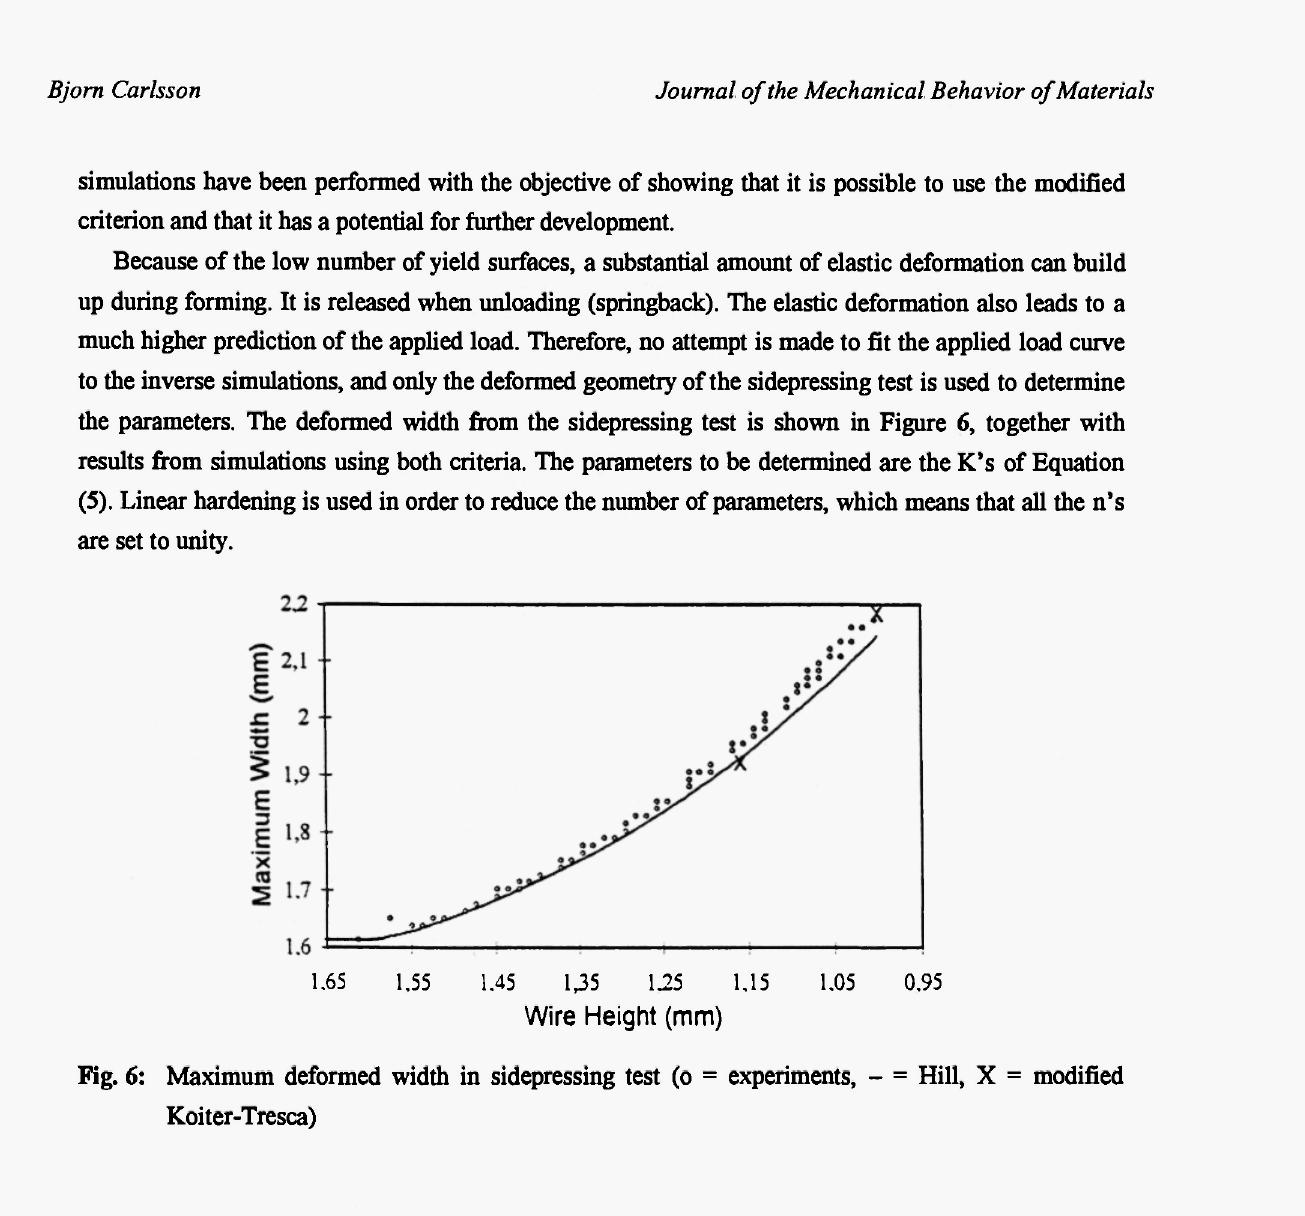
Fig. 6: Maximum deformed width in sidepressing test (o = experiments, - = Hill, X = modified